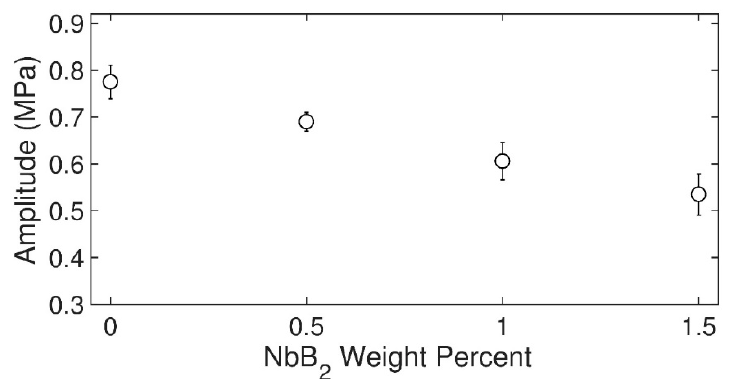
Figure 8. The amplitude of signal PLC in solution-treated alloys bearing different amounts of nanoparticles.